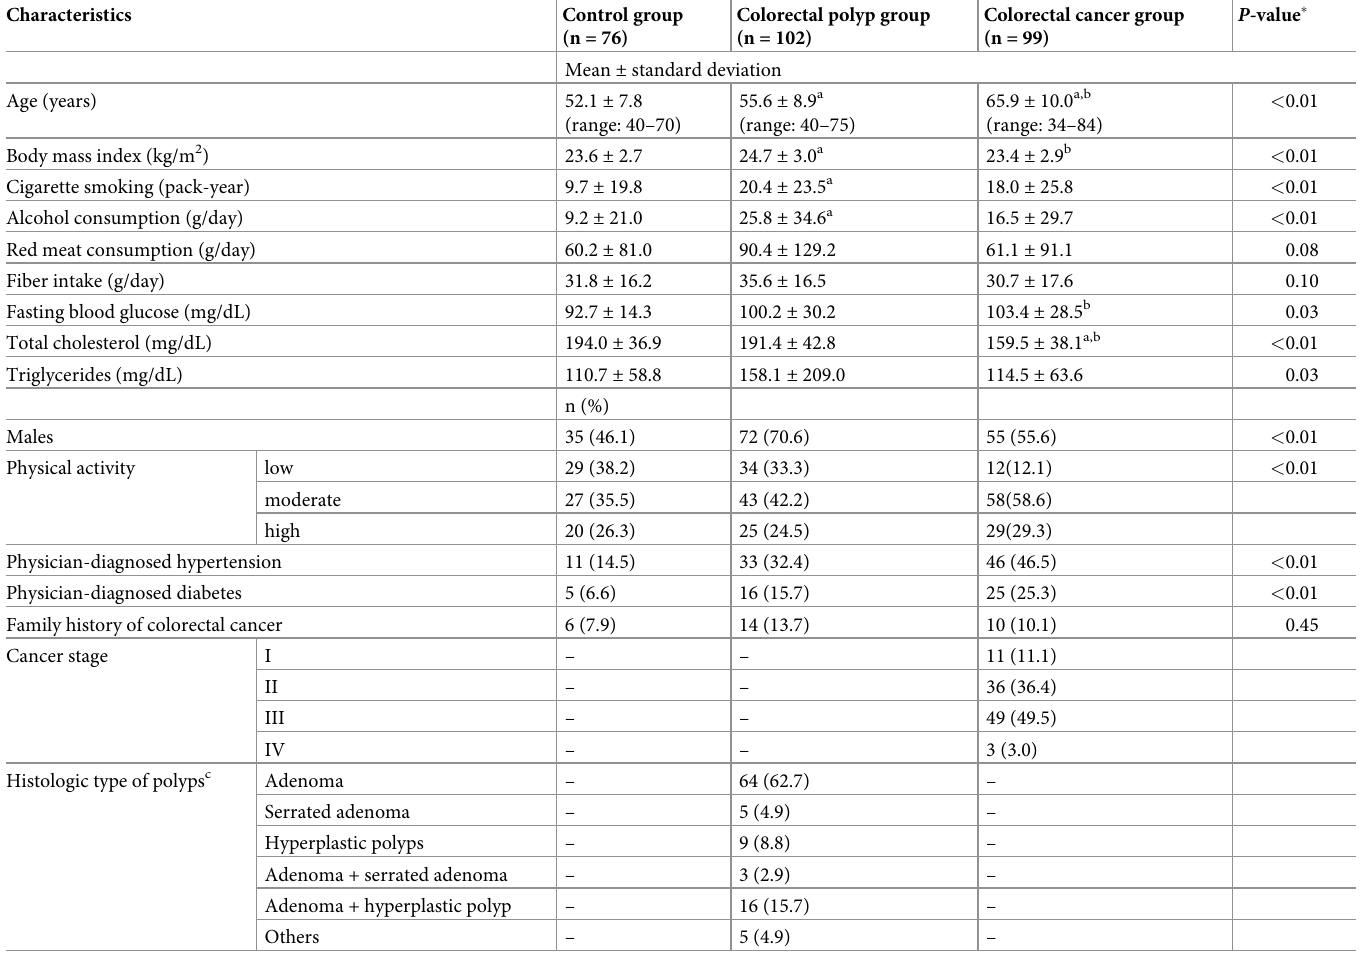
Table 1. General characteristics of subjects from the control, colorectal polyp, and colorectal cancer groups.